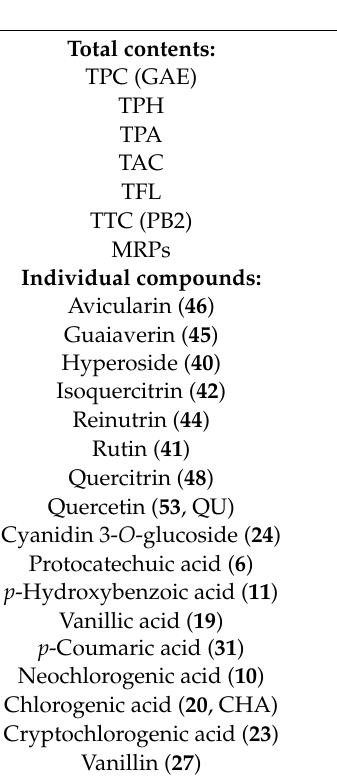
Table 1. Quantitative profile of the Prunus spinosa dried fruit extracts (mg/g dw). MED DEFD EAFD